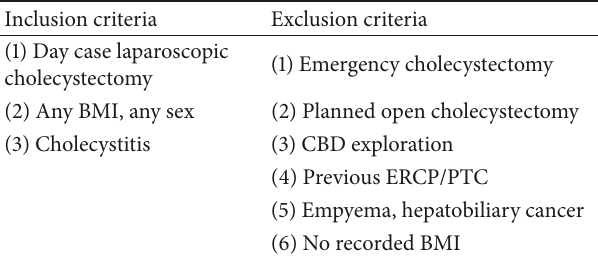
Table 1: Inclusion and exclusion criteria. Table 2: Patient demographics.